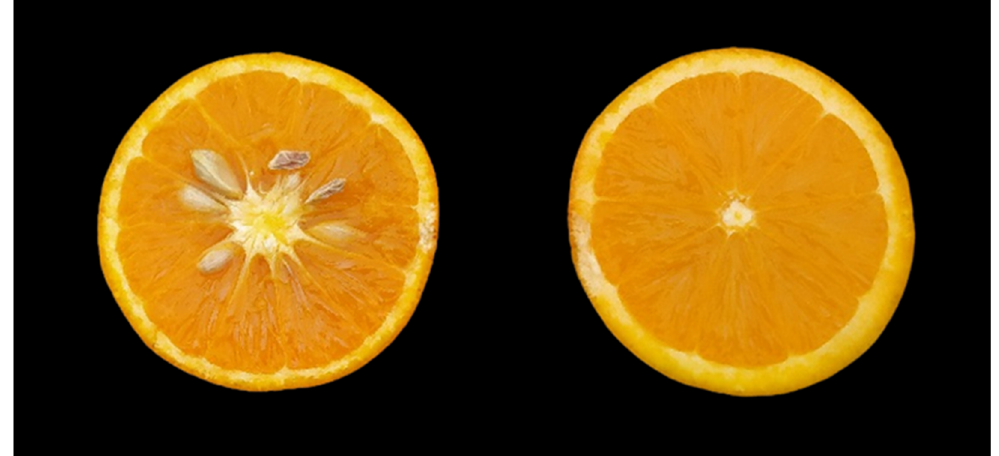
Figure 4. Fruit of “Ovale” orange ( right ) compared to a seedy fruit originated from a chimeric branch of the old “Ovale” line ( left ). of the old “Ovale” line ( left